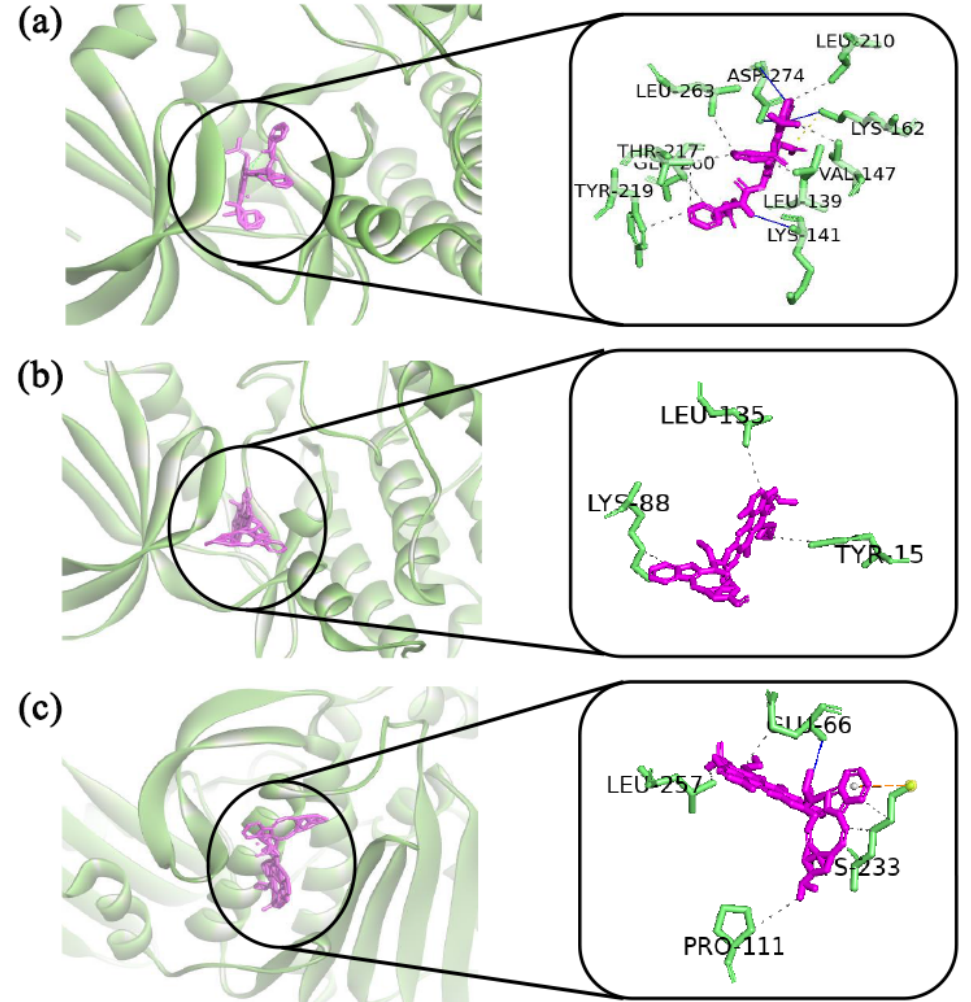
Figure 7. The top-ranked three complexes obtained from molecular docking study and their two-dimensional chemical interactions showed in the right side. The figure is generated by using discovery studio visualizers, PLIP and PyMol software. Complexes: ( a ) indicated AURKA_paclitaxel, ( b ) indicated CDK1_pinorelbine, and ( c ) indicated TOP2A_pincristine.